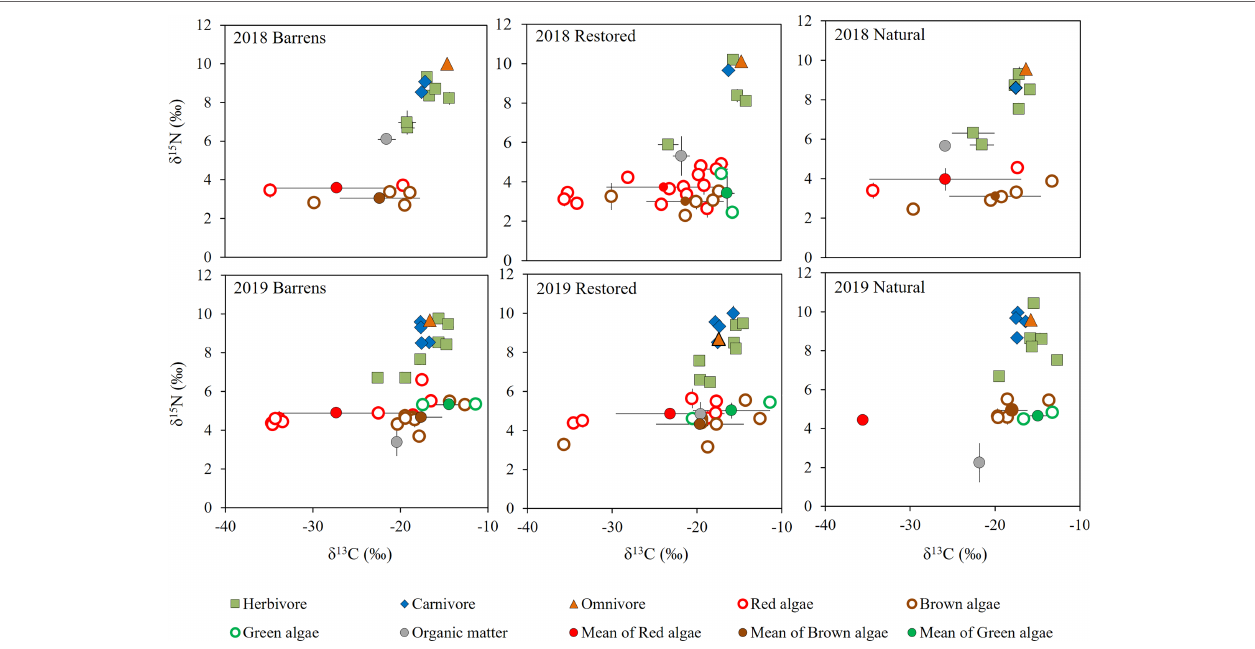
FIGURE 4 | Bi-plots of mean δ 13 C and δ 15 N values of potential diet resources and consumers in each year and site in this study. Vertical and horizontal error bars represent the standard errors of each sample ( n = 3). Filled circles indicate the average of overall chlorophytes, phaeophytes, and rhodophytes occurring in barrens, restored bed, and natural bed in 2018 and 2019, respectively.